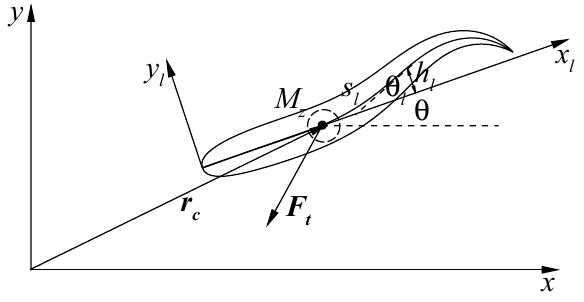
Figure 2. A schematic illustration of the motion of the